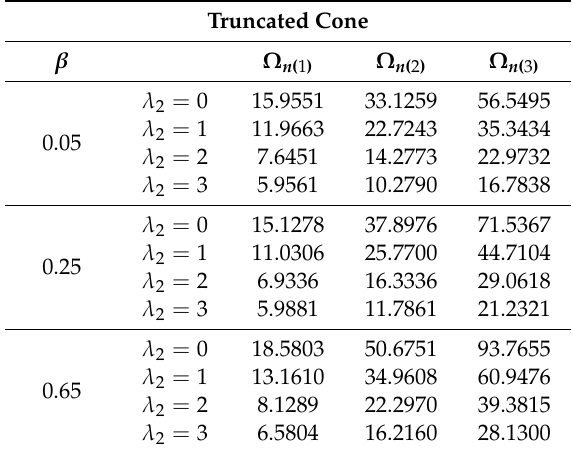
Table 4. E ff ect of thrust magnitude on the natural frequency of the first three